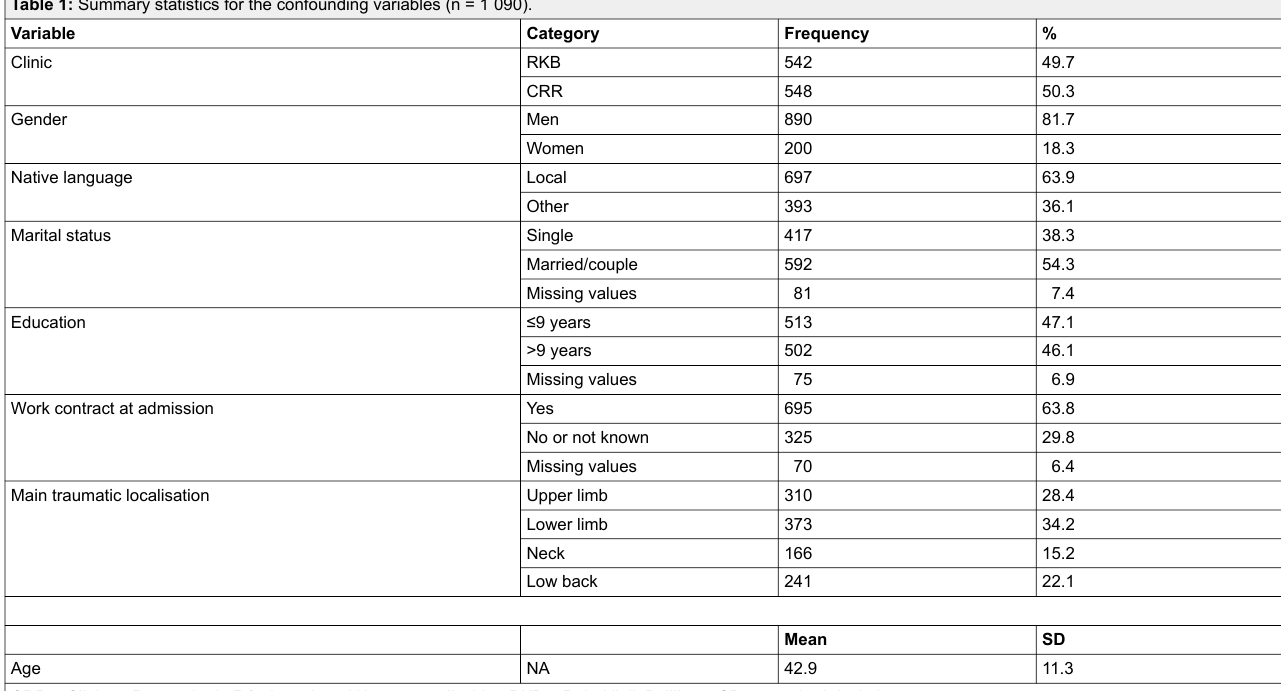
Table 1: Summary statistics for the confounding variables (n = 1 090).